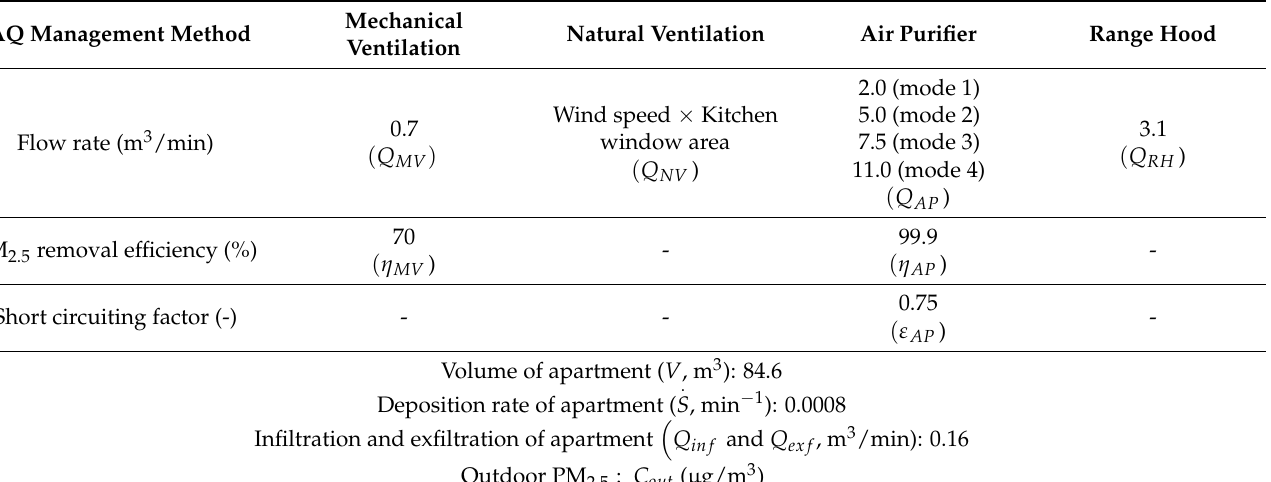
Table 1. Parameters of the theoretical